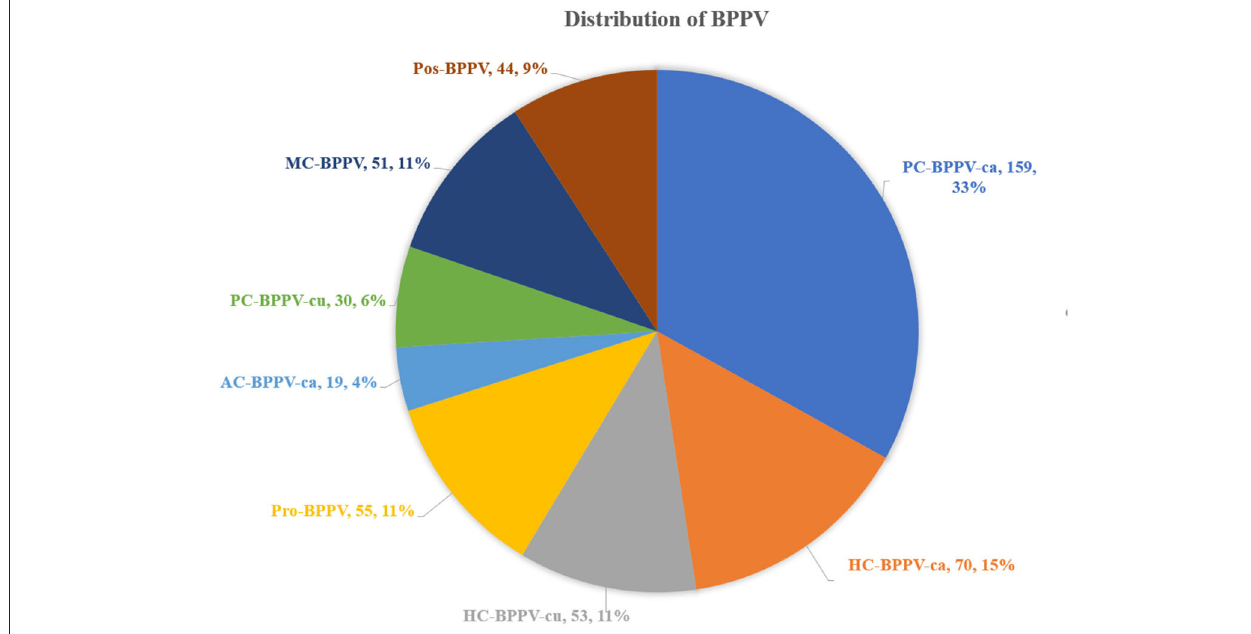
FIGURE 2 | Distribution of all types of BPPV. AC, anterior canal, ca, canalolithiasis, cu, cupulolithiasis; BPPV, benign paroxysmal positional vertigo, HC, horizontal canal, MC, multiple canal, PC, posterior canal, Pro, probably spontaneously resolved, Pos, possible.